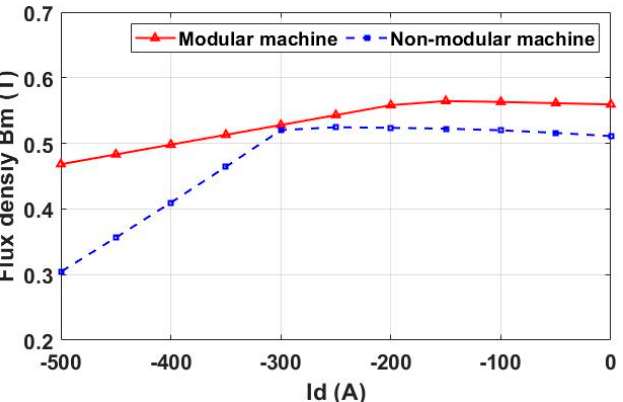
Figure 7. Minimum magnet flux density (radial component) at 20 °C at point A vs. the d-axis current for the investigated machines.